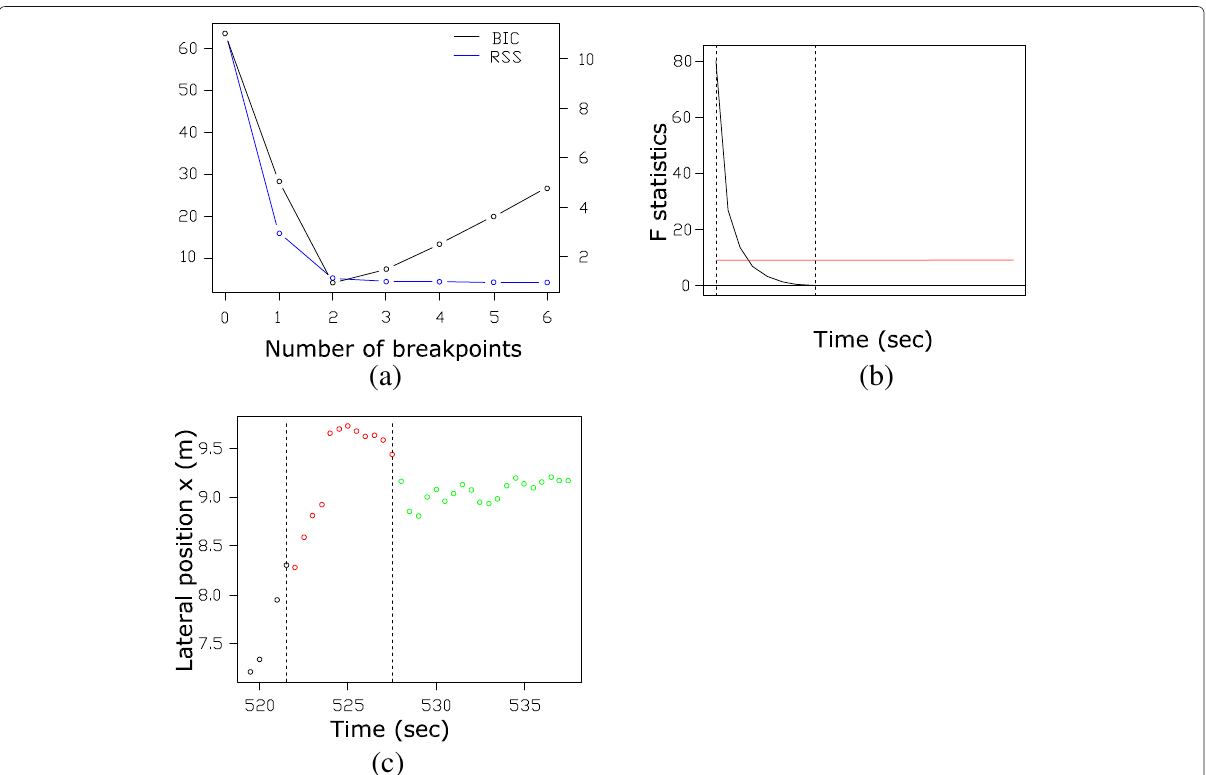
Fig. 11 a Optimal number of breakpoints using BIC and RSS for vehicle 848, b Breakpoints indicated by F-statistics for vehicle 848, c Lateral positions and breakpoints for vehicle